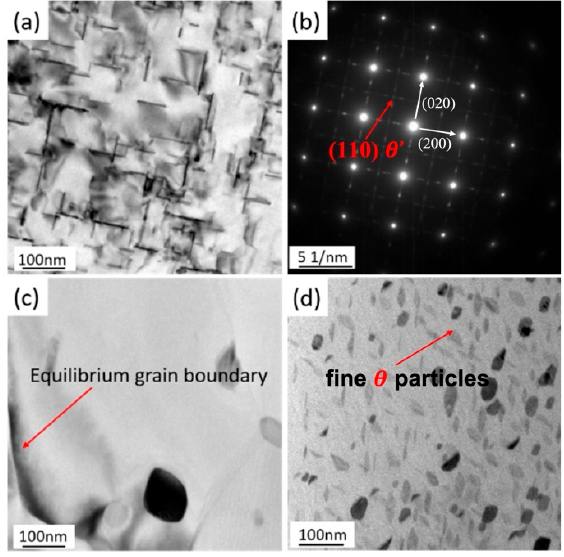
Figure 7. TEM images of the samples: ( a ) BM ( b ) corresponding SAED pattern of BM ( c ) FSW nugget zone ( d ) UAFSW nugget zone.